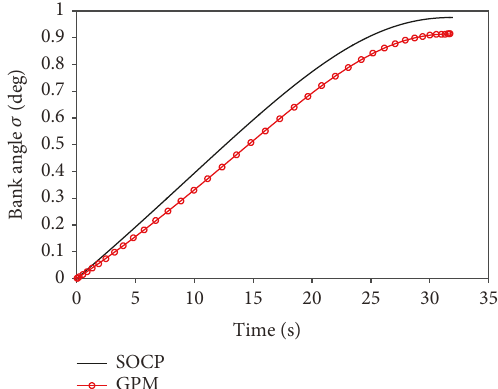
Figure 6: The penetrator ’ s banking angle pro fi les, using the two